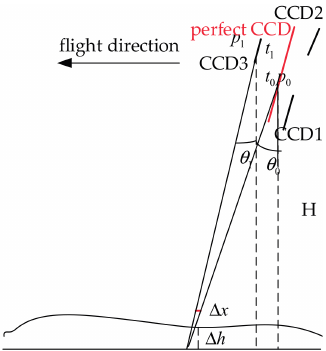
Figure 6. Parallax caused by height error.